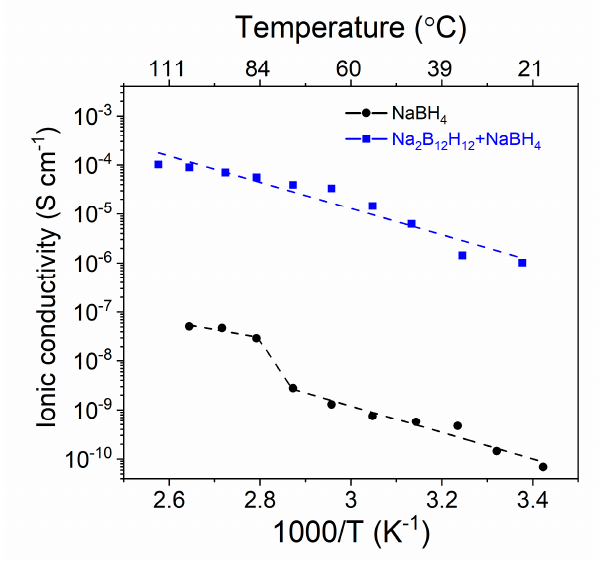
Figure 5. Arrhenius plot of NaBH 4 and the NaBH 4 +Na 2 B 12 H 12 composite synthesised by exposing NaBH 4 to B 2 H 6 .